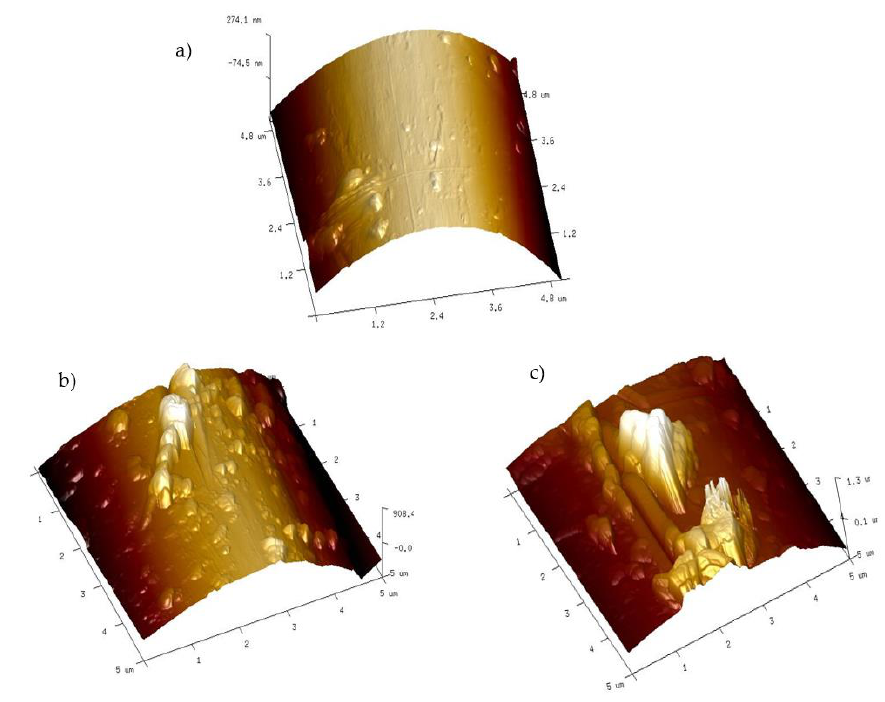
Figure 15. Atomic Force Microscopy (AFM) topography of a fiber pulled out after brittle fracture of the composites with matrices: EP ( a ), EP+3%BAQAS ( b ), EP+3%BAQPS ( c ).